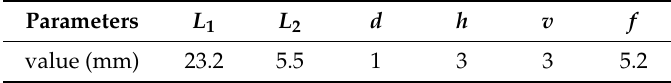
Figure 18. Geometry of the resonant coil and MedRadio antenna: ( a ) Top, ( b ) side, and ( c ) bottom. Table 1. Parameters of the designed antenna.